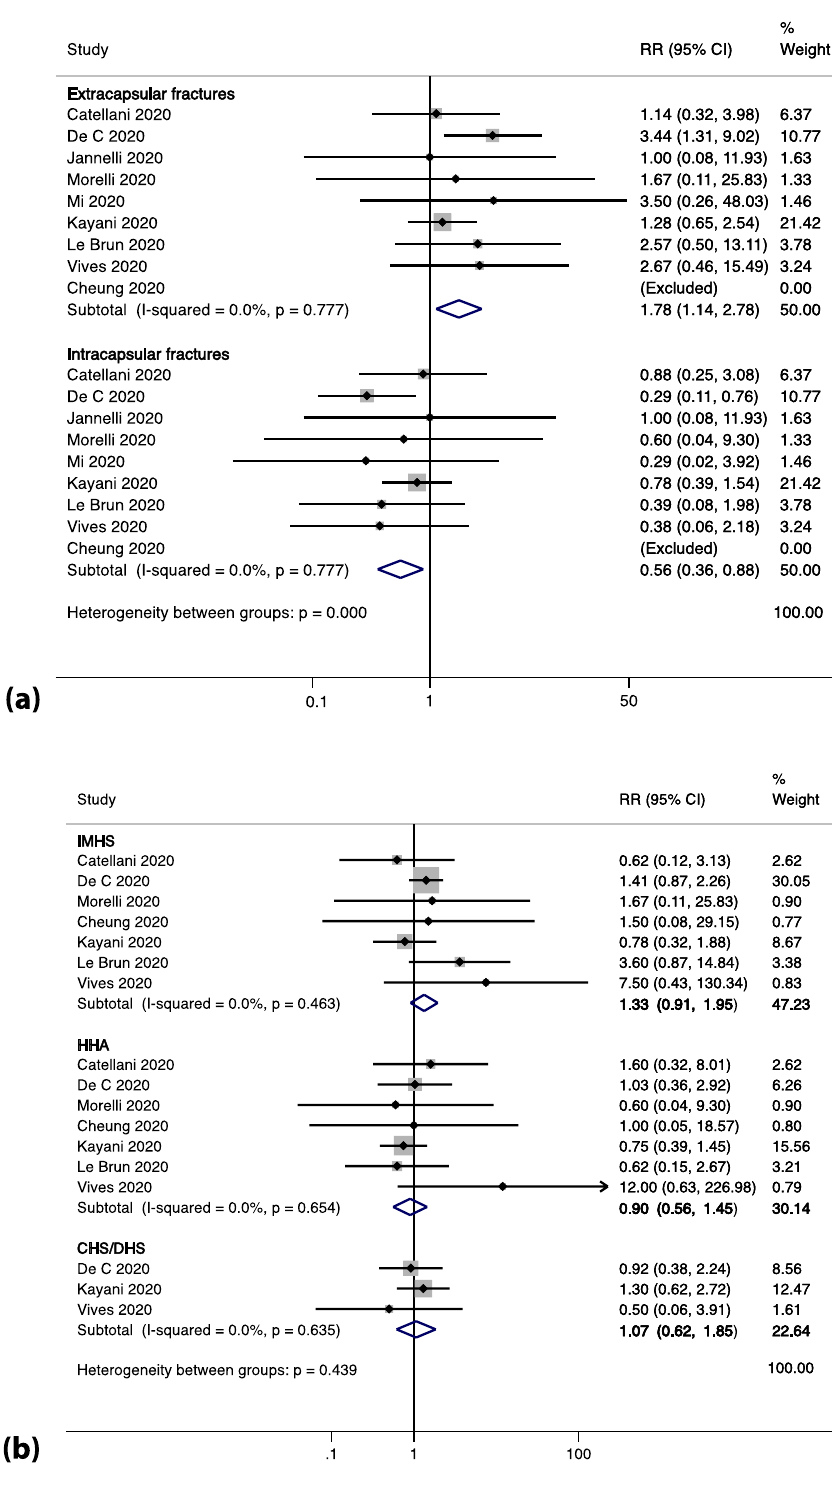
Figure 8. ( a ) Shows the forest plot for the type of hip fracture in COVID-19 positive deaths. ( b ) Shows the forest plot for type of implant in COVID-19 positive